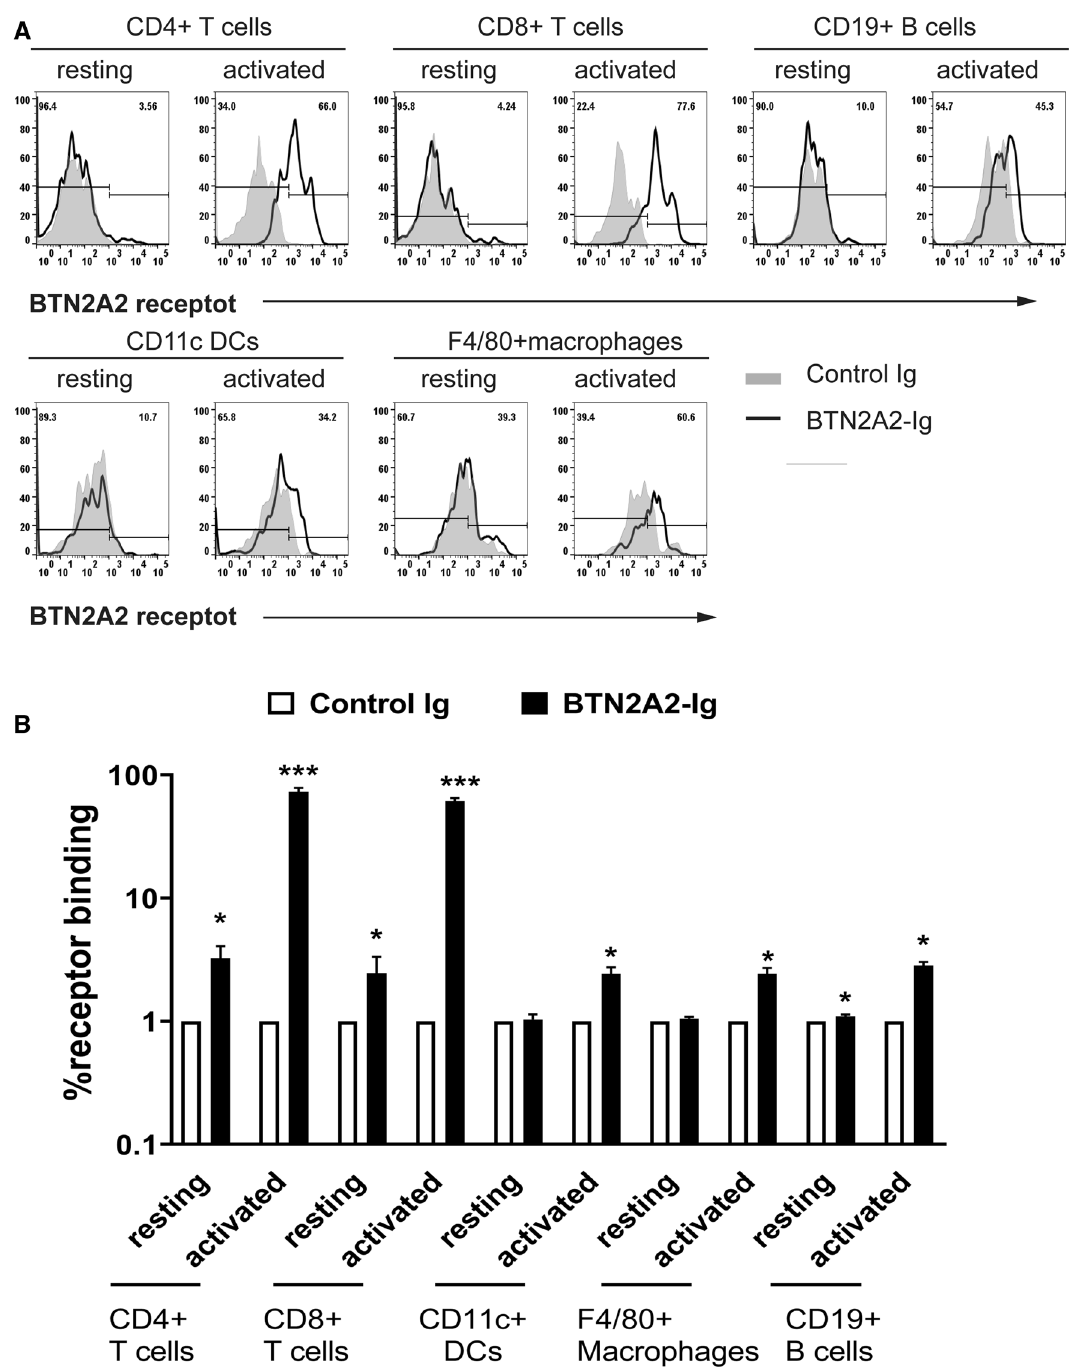
Figure 2. The expression pattern of the putative BTN2A2 receptor on immune cells. Resting and activated immune cells were prepared as Fig. 1. The immune cells were incubated with biotinylated BTN2A2-Ig or control Ig protein for 4 h, followed by PE conjugating streptavidin and antibodies against CD4, CD8, CD11c or F4/80 or CD19. ( A ) Representative flow cytometric profiles and ( B ) statistical analysis showing the binding of BTN2A2-Ig or control Ig to resting and activated immune cells. Data are presented as the percentage of cell binding of BTN2A2-Ig versus control Ig. *P < 0.05 compared with control Ig. **P < 0.05 compared with resting cells. The data are representative of three independent experiments with similar results. (n = 3 each